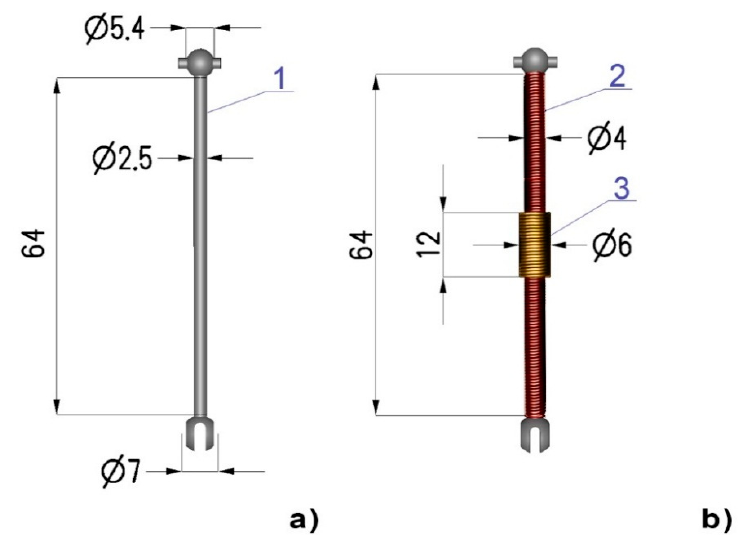
Figure 6. Geometry of the tested shaft: ( a ) shaft dimensions, ( b ) coil arrangement diagram; 1: shaft, 2: driving coil, 3: sensing coil. All dimensions are given in mm.